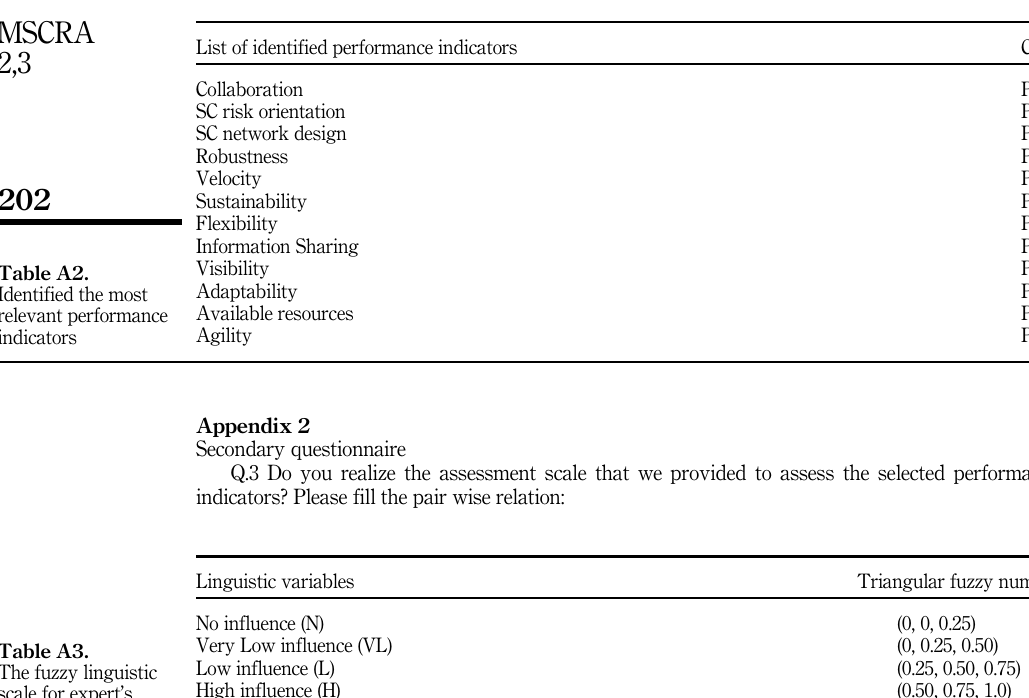
Table A3. The fuzzy linguistic scale for expert ’ s evaluation